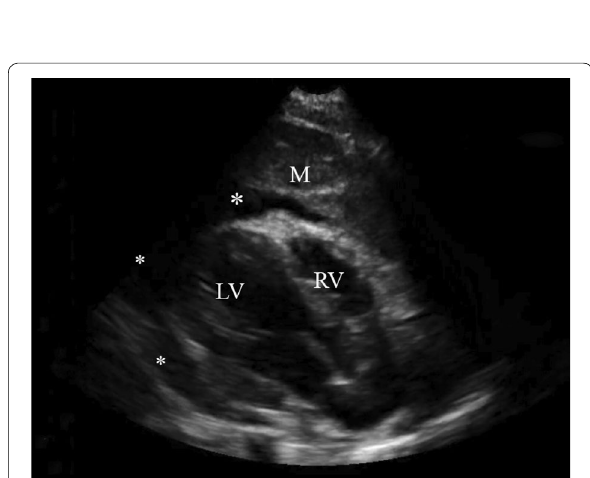
Fig. 3 POCUS, Case 2. Parasternal long-axis view, revealing a circumferential pericardial effusion (*) and an anterior mediastinal mass (M). For orientation, the left ventricle (LV) and right ventricle (RV) can be visualized in this